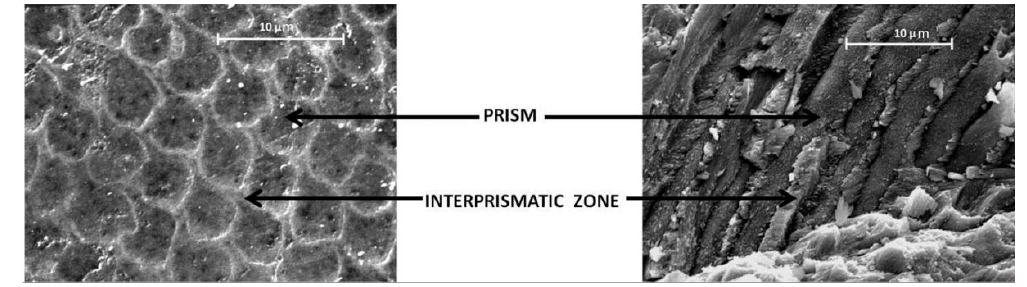
Figure 2. Prisms of the enamel observed on the surface and in cross-section.